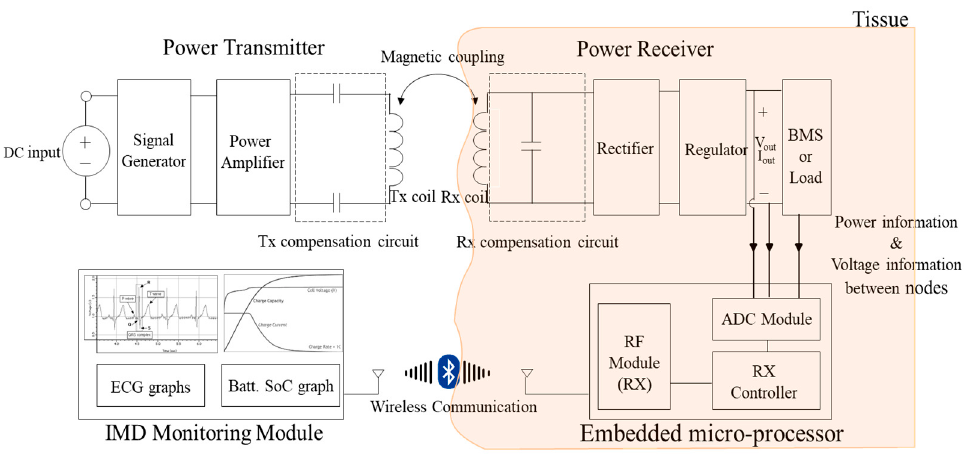
Figure 7. Block diagram of the proposed WPT-based IMD cardiac monitoring system.